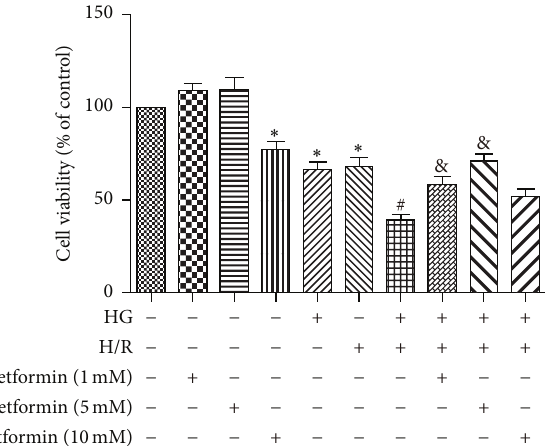
Figure 1: Dose-dependent effects of metformin on HG + H/R induced reduction in cell viability. H9C2 cells were treated with different concentrations of metformin (0, 1, 5, and 10mM). A “+” symbol indicates presence and a “ − ” symbol indicates absence of the relevant treatment condition, such as HG (33 mM), H/R, and various concentrations of metformin. Cell viability of each group was estimated using the CCK-8 assay. Data are shown as means ± SD of 3 independent experiments. ∗ 𝑃 < 0.05 versus Control; # 𝑃 < 0.05 versus HG or H/R; & 𝑃 < 0.05 versus metformin + HG +